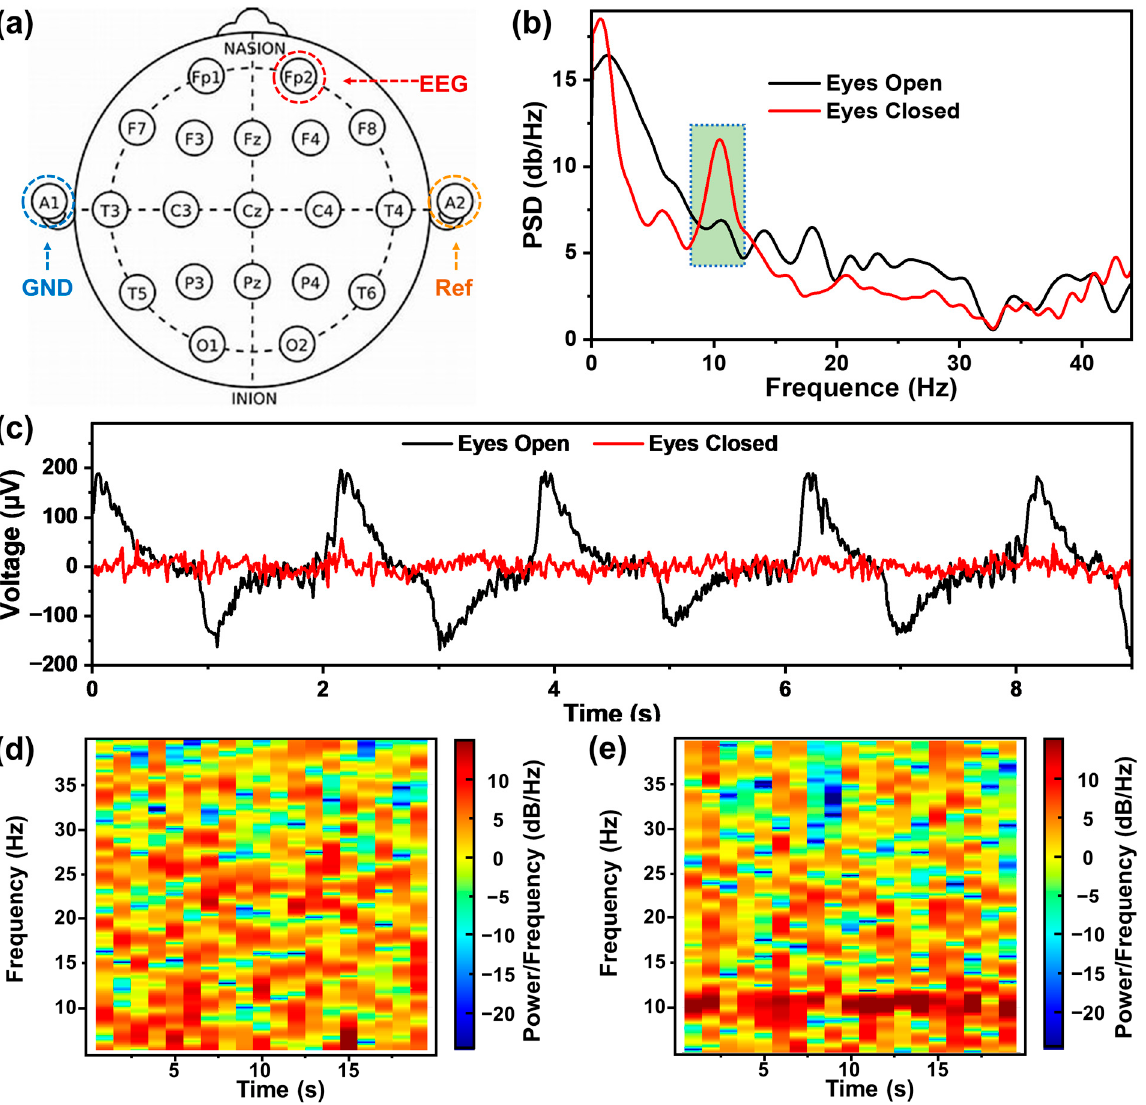
Figure 7. ( a ) Schematic illustration of electrode placement for the eye-open/eye-close EEG signal recording. ( b ) EEG power spectral density (PSD) of the eyes-open and eyes-closed periods. (The dashed box is to highlight the peak at 10 Hz.) ( c ) One channel EEG signal recorded during eyes blinking and rest. The time–frequency analysis of the signal from 0.5–45 Hz during ( d ) eyes open and ( e ) closed.